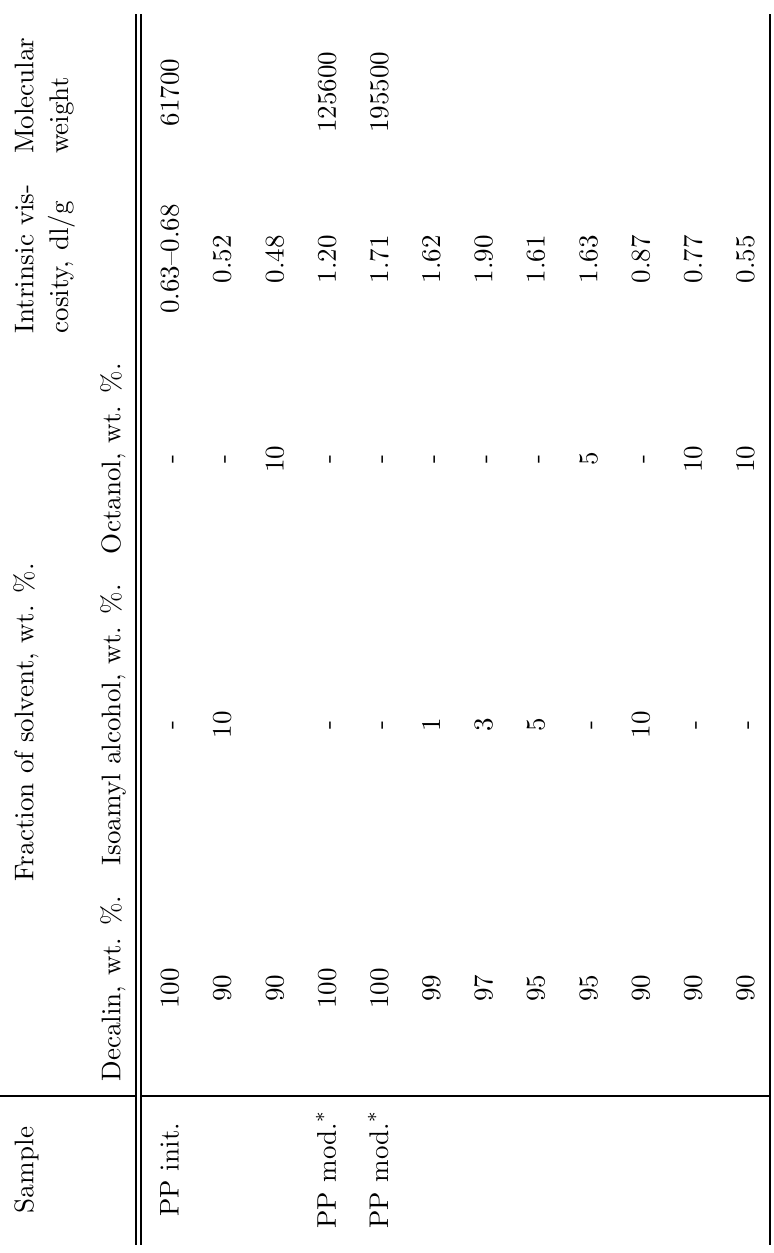
Table 3 Values of intrinsic viscosity of initial and modi› ed PP. NB: PP mod. * - PP modi› ed maleic